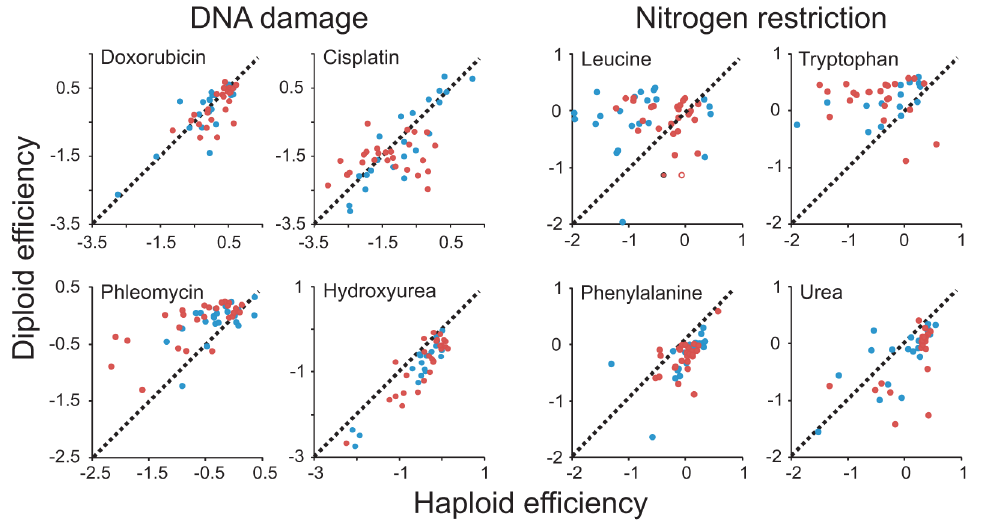
Figure 3. Patterns of ploidy–environment interactions refute generalizing hypotheses on the effects of mutational load, toxin exposure, and nutrient restriction. Performance of haploid (n=4) and diploid (n=2) versions of individual S. cerevisiae (blue) and S. paradoxus (red) strains in DNA damage inducing environments and nitrogen restricted environments. Note that data is shown on a log(2) scale. Broken lines indicate the 1:1 correlation (null hypothesis expectation).